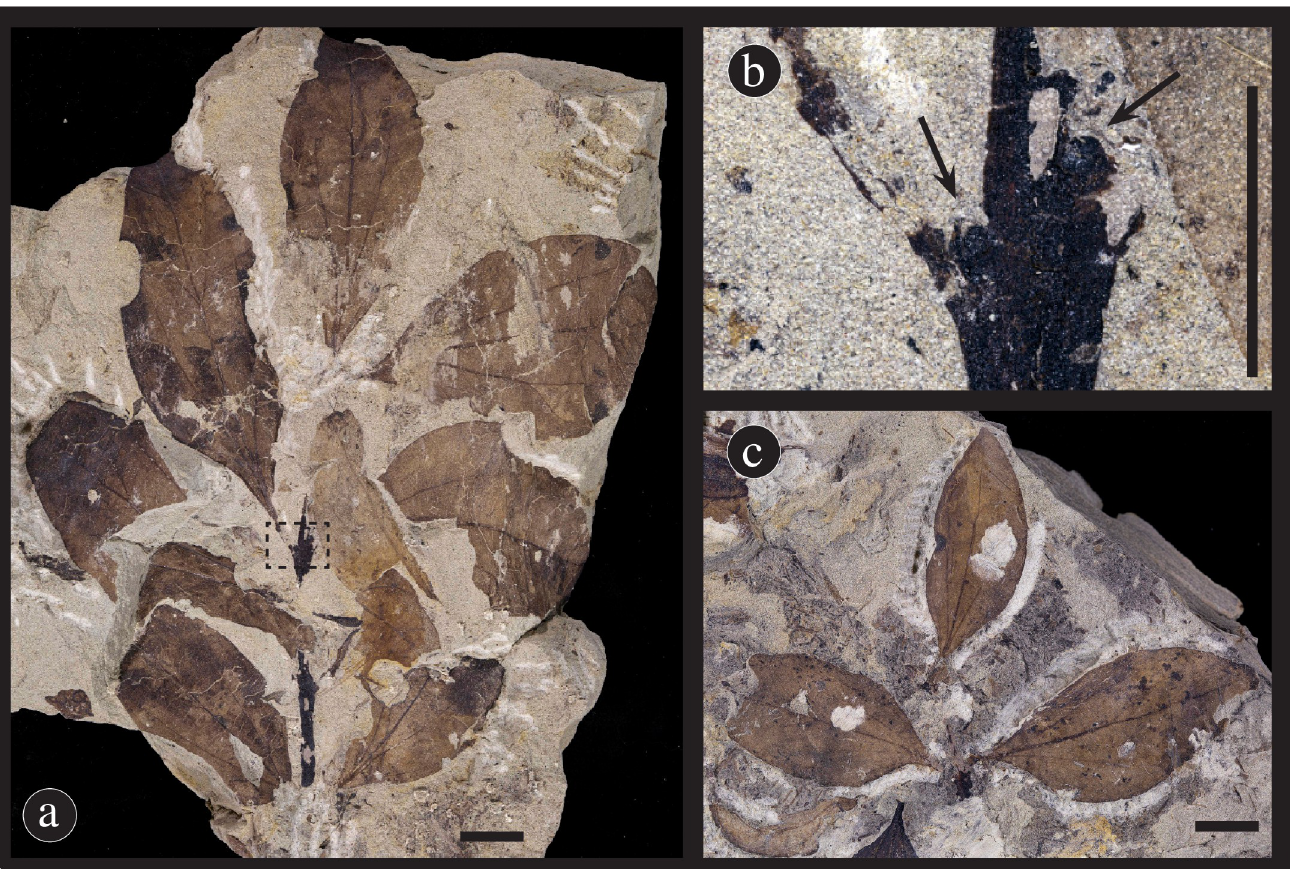
Fig 5. Paratype specimens of Catula gettyi . (A) Attached leaves of C . gettyi on a stem showing opposite leaf attachment, probable distichous arrangement, and an odd-pinnate leaf terminus (DMNH 54378). Scale bar = 1 cm. (B) Enlarge section of dashed inset box in Fig 4 a showing leaf attachment (DMNH 54378). Arrows highlight axillary buds. Scale bar = 0.5 cm. (C) Attached leaves of C . gettyi on a stem showing opposite leaf attachment and an odd-pinnate leaf terminus (DMNH 54377). Scale bar = 1